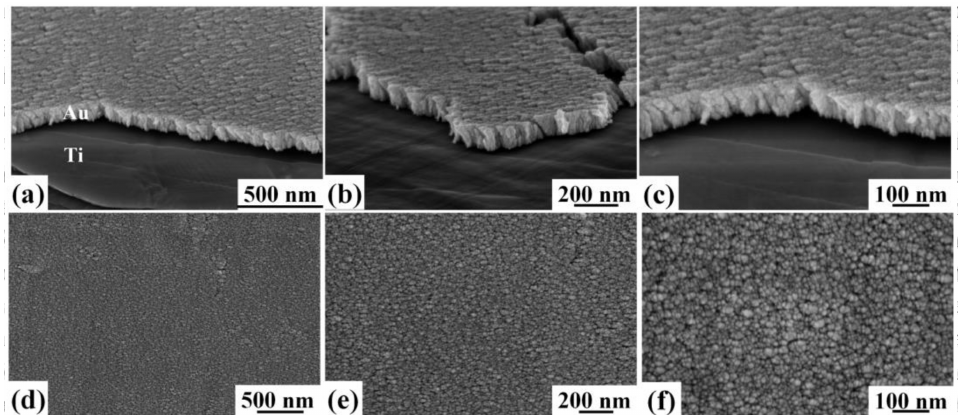
Figure 4. Cross-section (( a – c ), with magnification increase from ( a ) to ( c )) and plan-view (( d – f ), with magnification increase from ( d ) to ( f )) SEM images of the thinner (140 nm-thick) Au film deposited at θ = 48 ◦ on Ti (sample B1).